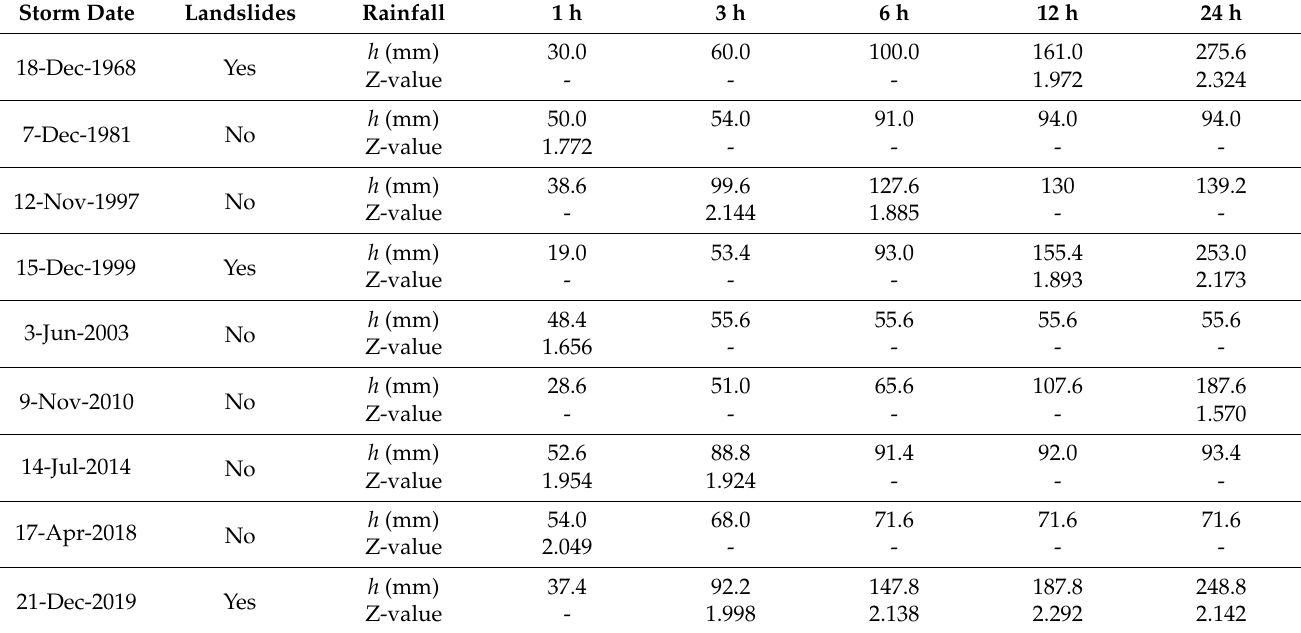
Table 7. S. Martino V.C. rain gauge (R1): actual maximum rainfall intensities h (mm) and Z-values of the storms of the historical series (1966–2020) characterized by hourly maxima falling in the severe (1.5 ≤ Z < 2) and extreme categories (Z ≥